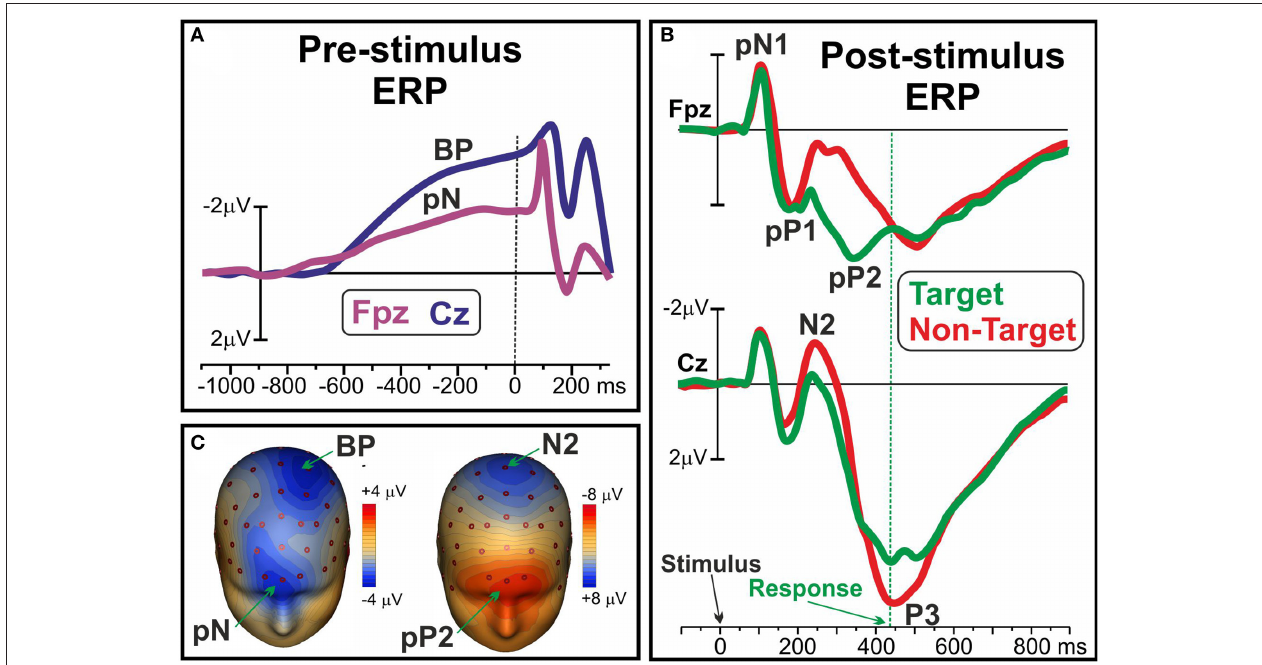
FIGURE 1 | (A) Pre-stimulus ERP waveforms of the pN and BP components over medial prefrontal (Fpz) and frontal sites (Cz), respectively. (B) Post-stimulus pN1, pP1 and pP2 ERP components over Fpz; N2 and P3 components at Cz. (C ) Scalp topography of the pN and BP (left), and of the pP2 and N2 (right). Data derived from Di Russo et al.